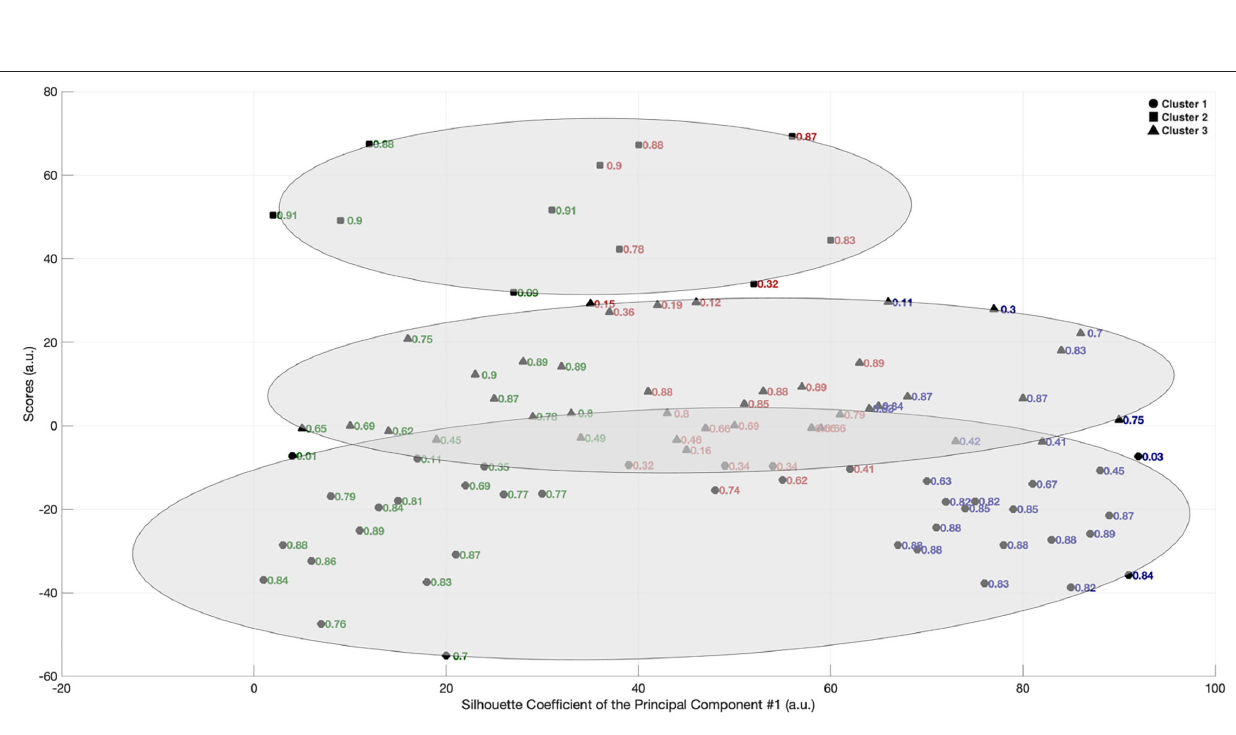
FIGURE 2 | Clustered principal component scores and correspondent silhouette coefficients related to the passing network metrics from Liverpool FC (green), Manchester FC (red) and Tottenham Hotspur (blue) in the 2017/18, 2018/19, and 2019/20 seasons of the UEFA Champions League, coached by Jürgen Klopp, Pep Guardiola and Mauricio Pochettino,